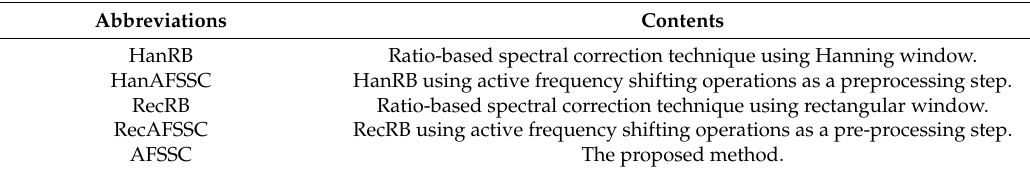
Table 1. Abbreviations of the proposed method and those of four comparison methods.